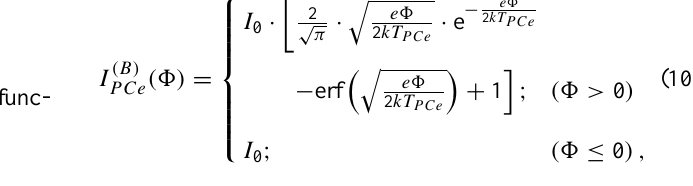
Fig. 2. The electron temperature of quiet ionospheric plasma as a function of its